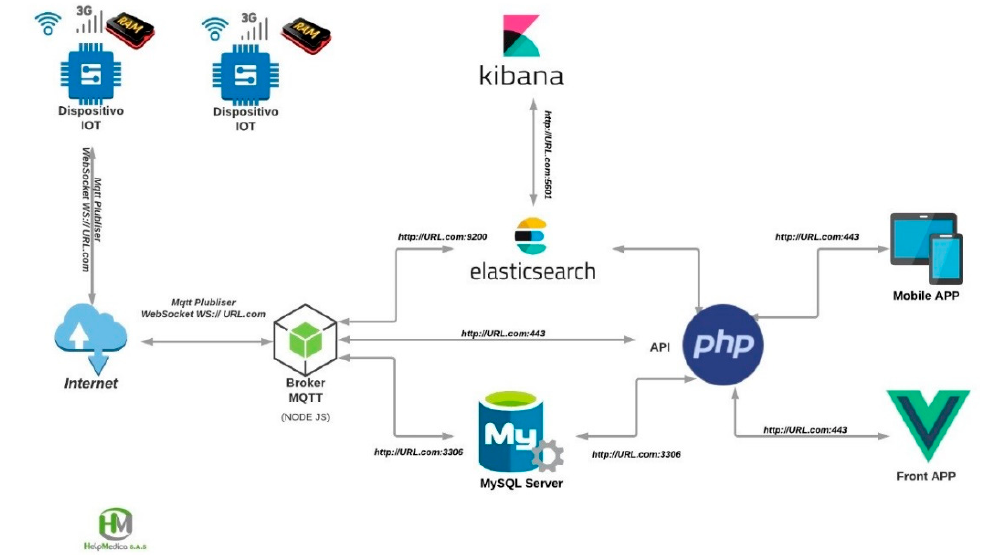
Figure 9. Components Diagram.